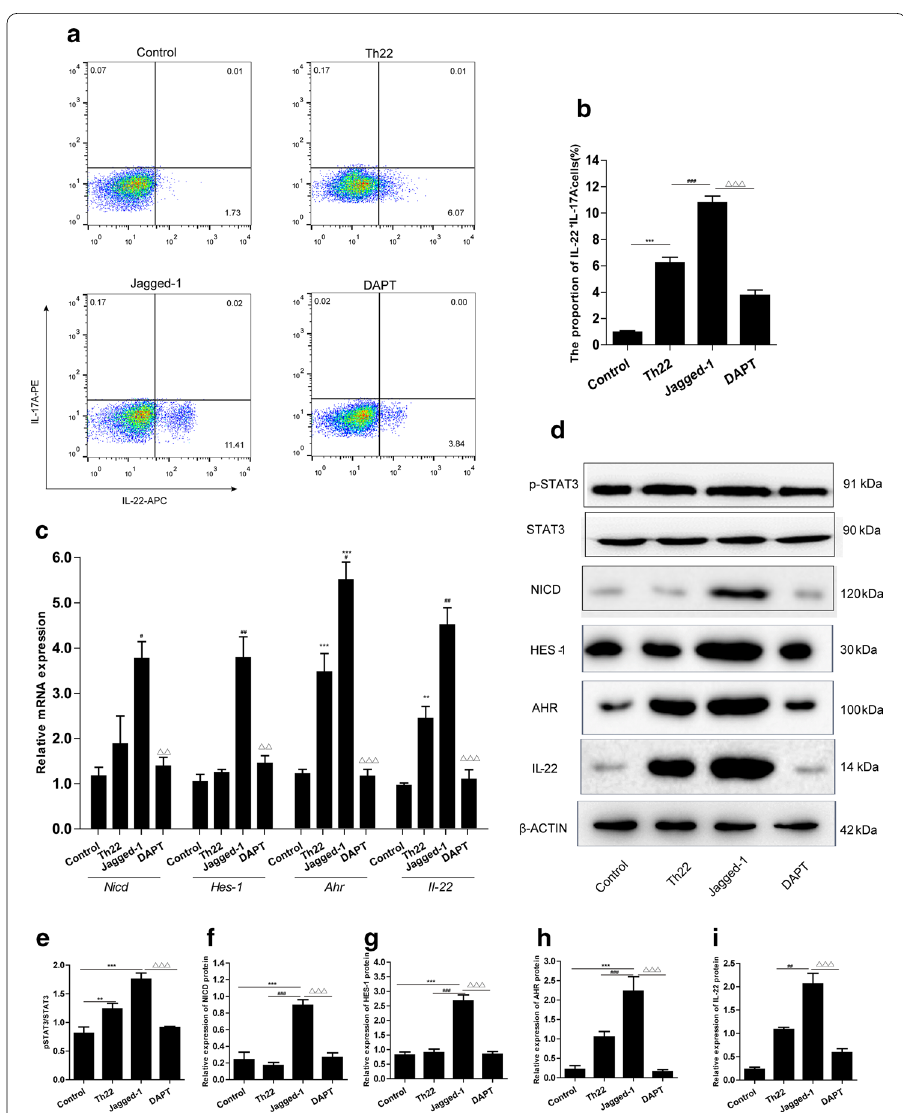
Fig. 3 NOTCH signaling pathway was involved in differentiation of CD4 + T cells towards Th22 cells. Naïve CD4 + T cells were cultured in conditions designed to induce Th22 differentiation, either 1 µg/mL jagged-1 treatment alone or jagged-1 combined with DAPT (10 µM). a The percentage of Th22 (CD4 + IL-22 + IFNγ − IL-17ˉ) cells was analyzed by flow cytometry in naïve CD4 + T cells treated with PBS, jagged-1 or jagged-1 plus DAPT. b Percentage quantitation of Th22 cells. c Gene expression of Nicd , Hes-1 , Ahr , and Ii-22 was analyzed by RT-PCR. d Representative western blot showing protein levels of p-STAT3, STAT3, NICD, HES-1, AHR, and IL-22 extracted from different groups. e i Densitometric analysis of p-STAT3, STAT3 NICD, HES-1, AHR, and IL-22 − levels was performed with Quantity One software and data were represented as the means S.E.M. of three ± different experiments. ** p < 0.01, *** p < 0.001, compared with control group; # p < 0.5, ## p < 0.01, ### p < 0.001, for jagged-1 versus Th22 groups; △△ p < 0.01, △△△ p < 0.001, for DAPT versus jagged-1